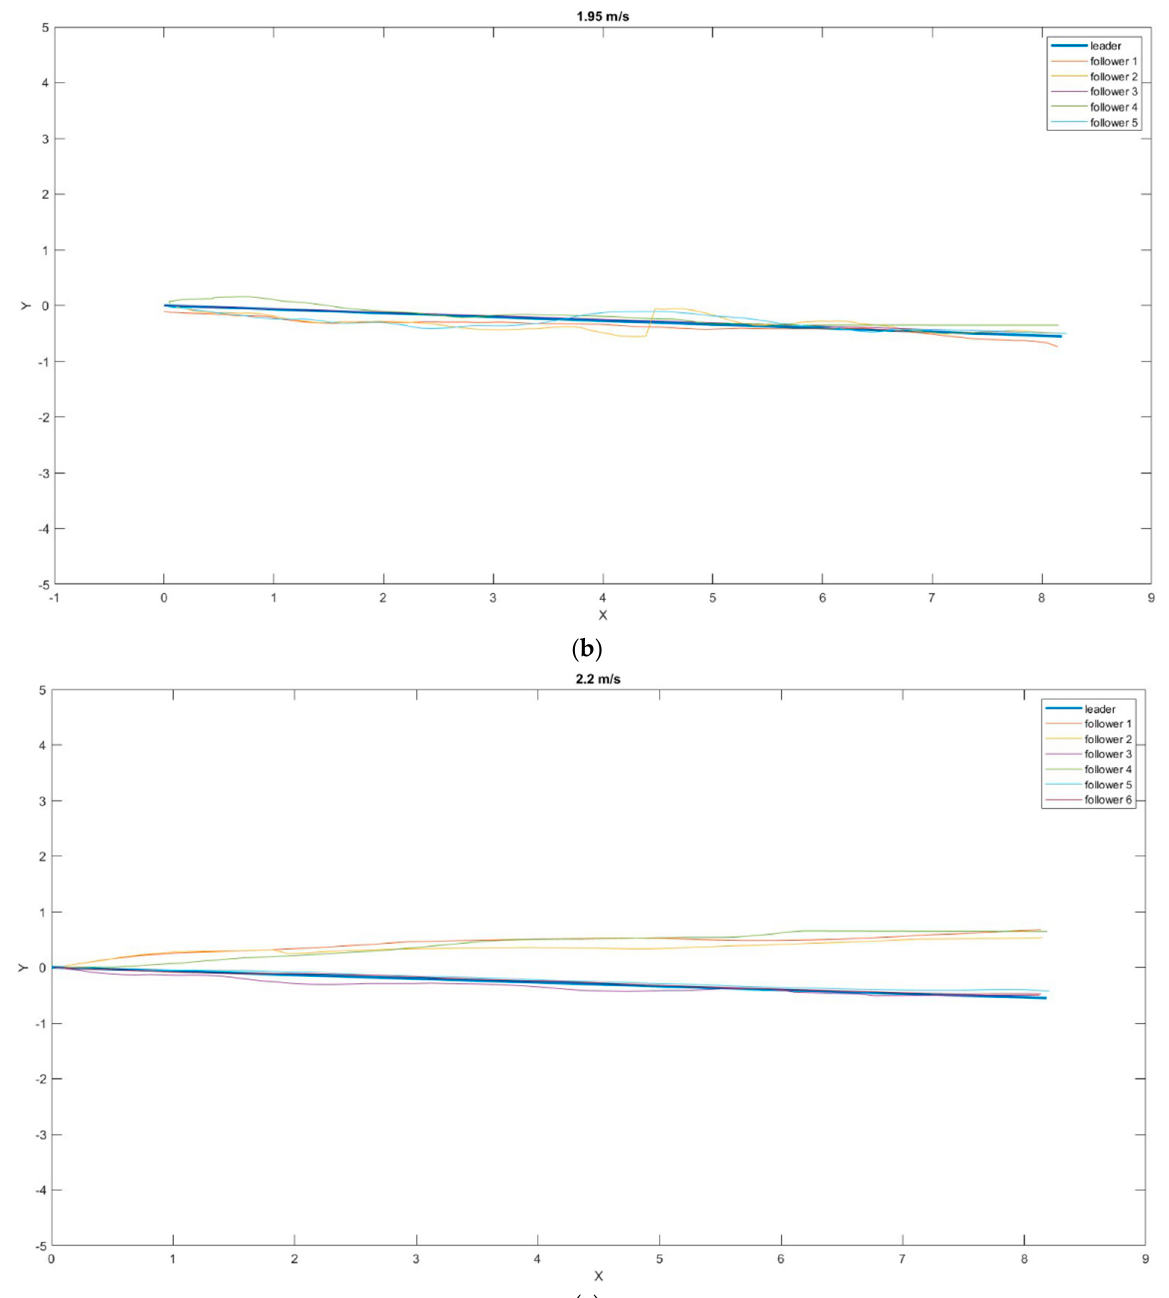
Figure 9. Position of the drones relative to the leader in the XY plane at different speeds: ( a ) 1.75 m/s; ( b ) 1.95 m/s; ( c ) 2.2 m/s.